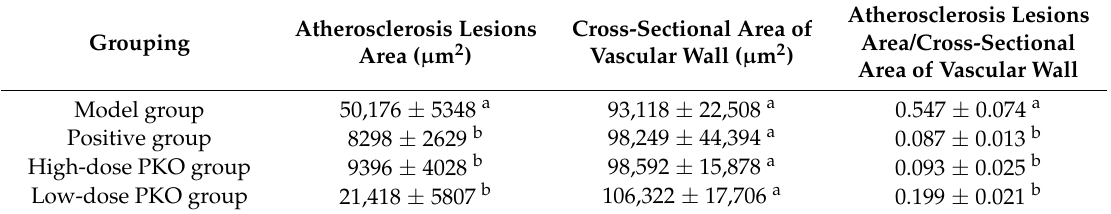
Table 1. The comparison of aortic atherosclerotic lesions area in mice ( X ± SD, n = 8).